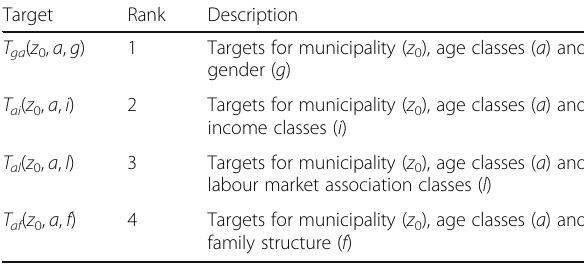
Table 1 Ranking of main targets in the National